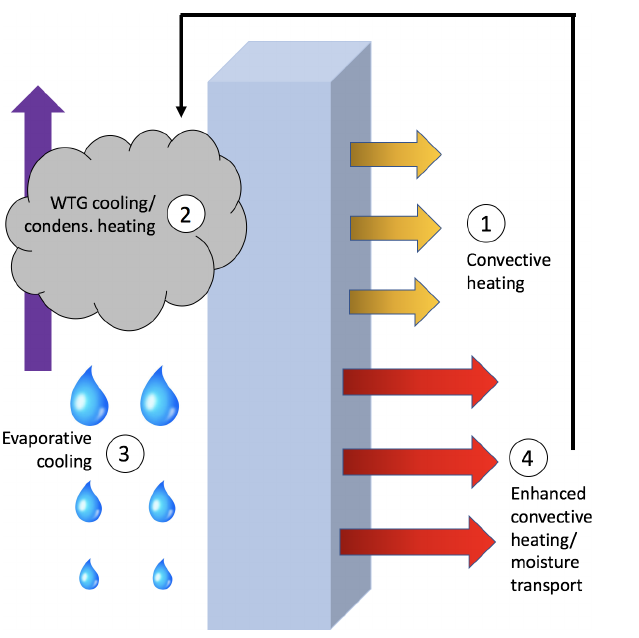
Figure 10. An illustration of the θ -forcing balances within the WRF SCM with WTG approximation and the order in which they appear to be established in the first few time steps. The 4 → 2 arrow signi- fies the convective parameterizations delivering moisture across the cloud base into the upper